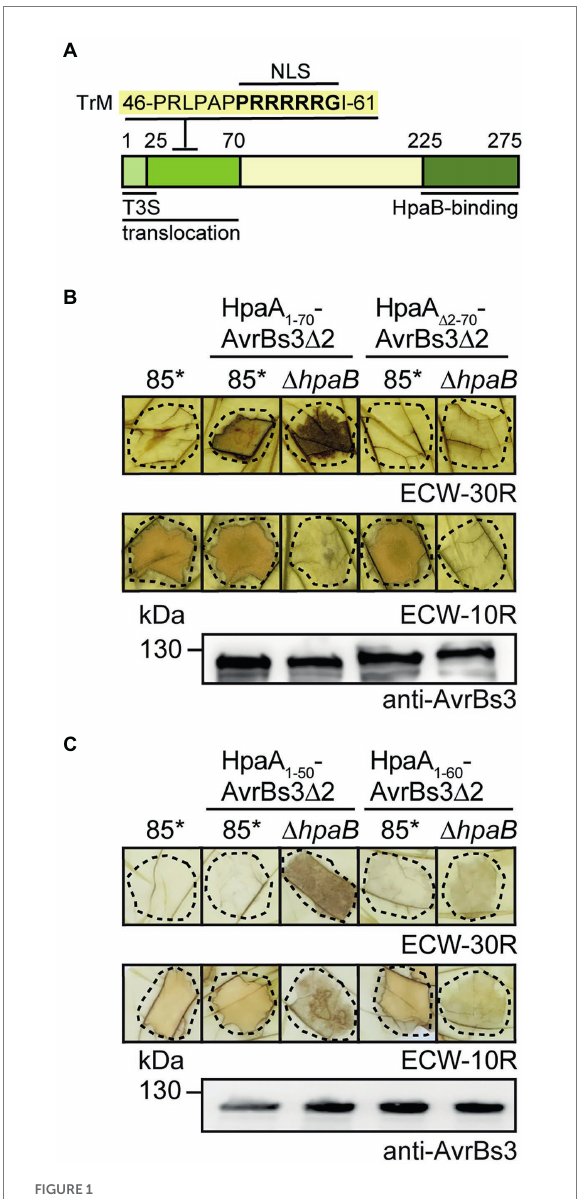
FIGURE 1 The N-terminal region is essential for HpaA translocation. (A) Schematic representation of functional regions in HpaA. Letters refer to the amino acid sequence of the N-terminal TrM, numbers indicate amino acid positions. The localization of the N-terminal T3S and translocation signal and the C-terminal HpaB-binding site is indicated (Lorenz et al., 2008a). TrM, translocation motif. (B) The N-terminal 70 amino acids are essential for HpaA translocation. X. euvesicatoria strains 85* and 85* ∆ hpaB with or without expression constructs encoding HpaA 1-70 -AvrBs3 ∆ 2 or HpaA -AvrBs3 ∆ 2 as ∆ 2-70 indicated were infiltrated into leaves of AvrBs3-responsive ECW-30R and AvrBs1-responsive ECW-10R pepper plants. Leaves were bleached in ethanol 2 dpi. Dashed lines indicate the infiltrated areas. For protein analysis, bacterial strains were grown in nutrient-yeast extract-glycerol (NYG) medium and equal amounts of protein extracts were analysed by immunoblotting using an AvrBs3-specific antiserum. (C) The N-terminal 50 amino acids of HpaA contain a minimal translocation signal. X. euvesicatoria strains 85* and 85* ∆ hpaB with or without expression constructs encoding HpaA 1- 50 -AvrBs3 ∆ 2 or HpaA 1-60 -AvrBs3 ∆ 2 as indicated were infiltrated into leaves of AvrBs3-responsive ECW-30R and AvrBs1-responsive ECW- 10R pepper plants. HR reactions and protein synthesis were documented as described in (B)